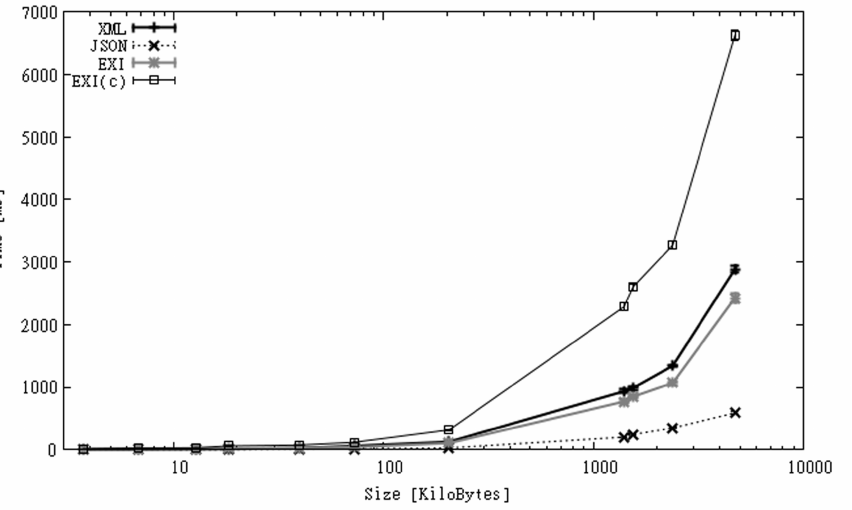
Figure 3. Parsing time for SGS2 smartphone (CAPS